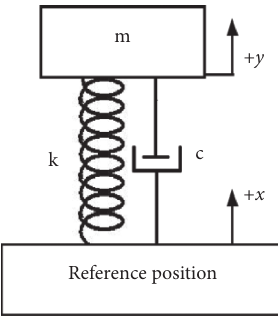
Figure 8: Dynamic model of the relative motion